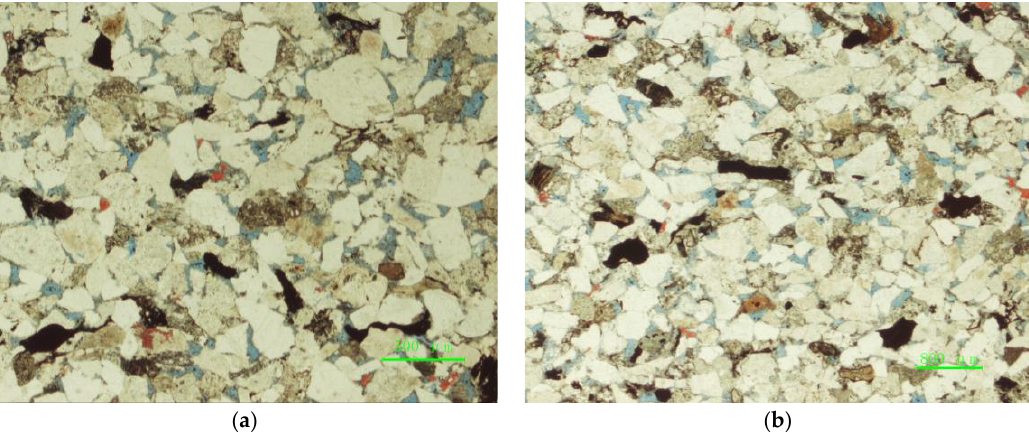
Figure 2. Images of cast body thin section analysis of tight sandstone gas reservoir samples. ( a ) medium-grained rock chips. ( b ) medium-fine-grained rock chips.